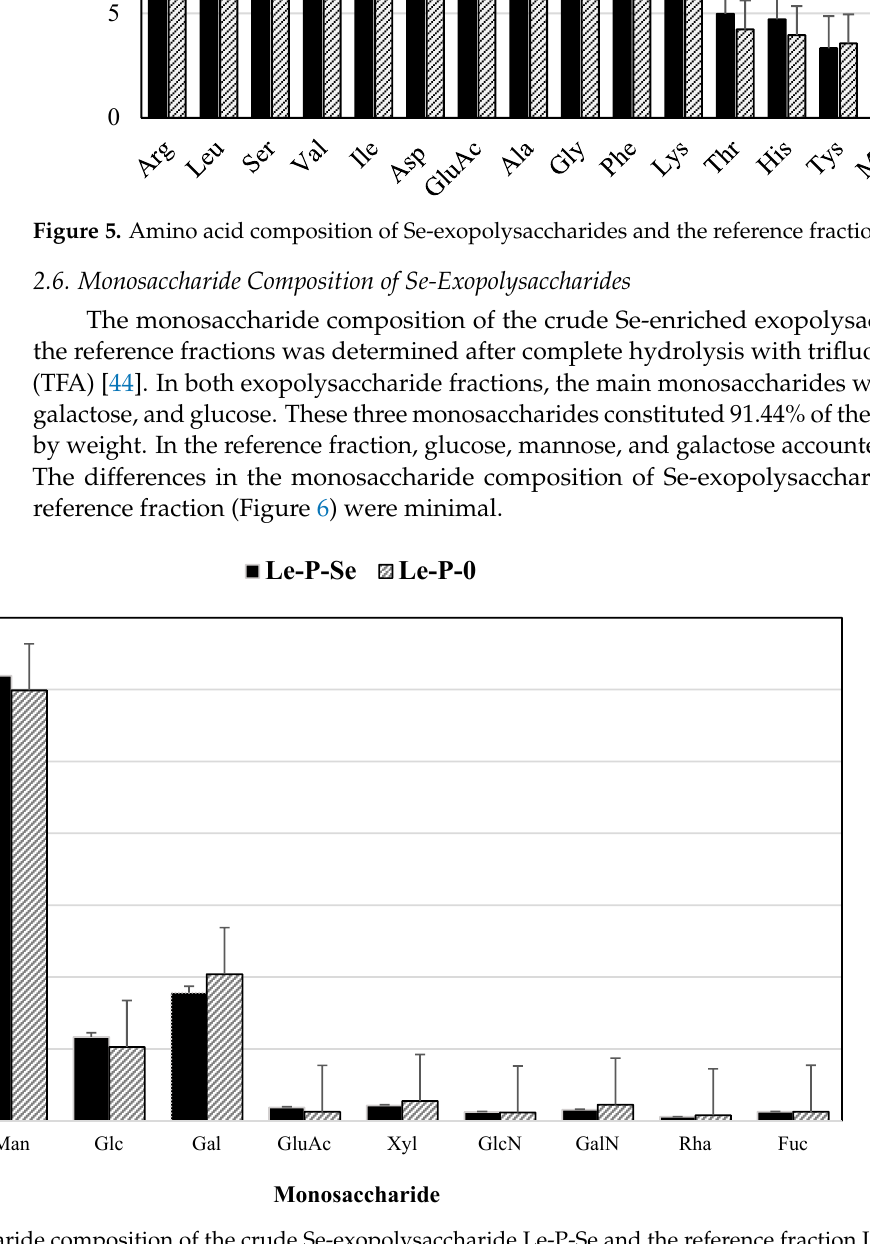
Figure 6. Monosaccharide composition of the crude Se-exopolysaccharide Le-P-Se and the reference fraction Le-P-0.